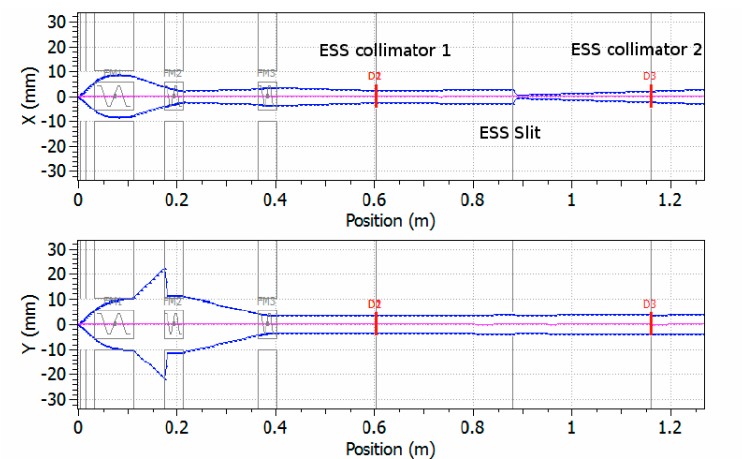
Figure 3. Horizontal envelop ( upper panel ) and vertical envelop ( lower panel ) of the beam line for a monochromatic beam (5 MeV) with a spot size of 100 µ m and 170 mrad half angle divergence.